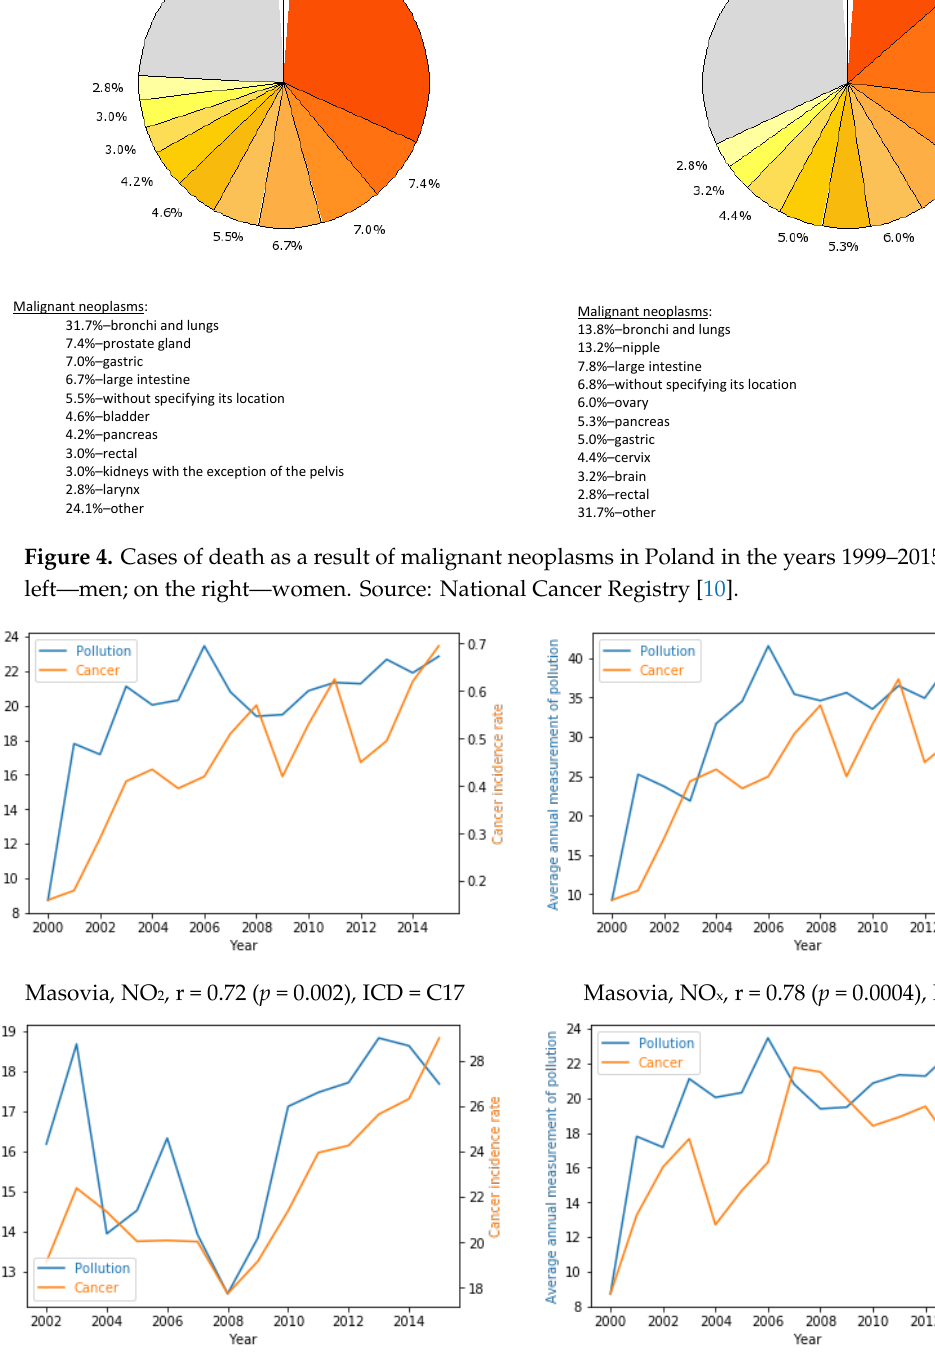
Figure 4. Cases of death as a result of malignant neoplasms in Poland in the years 1999–2015. On the left—men; on the right—women. Source: National Cancer Registry [10].